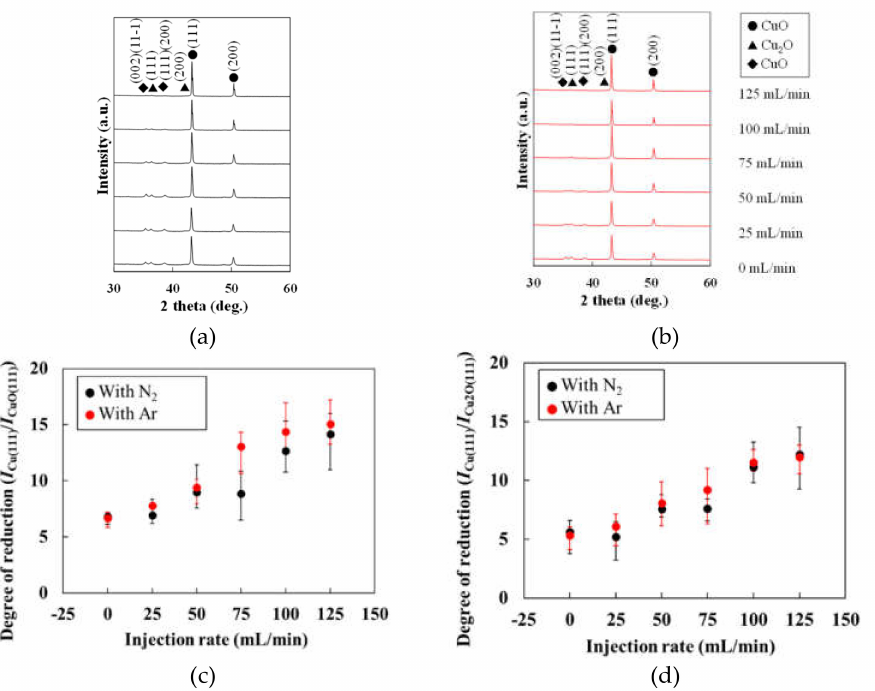
Figure 4. XRD spectra of the patterns fabricated under ( a ) N 2 gas and ( b ) Ar gas; degrees of reduction, ( c ) Cu/CuO and ( d ) Cu/Cu 2 O of the patterns fabricated under gases with various injection rates.